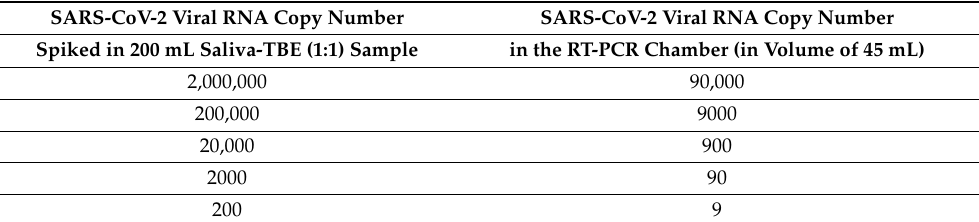
Table 1. On-cartridge detection of SARS-CoV-2 directly from saliva samples, input vs. output. SARS-CoV-2 Viral RNA Copy